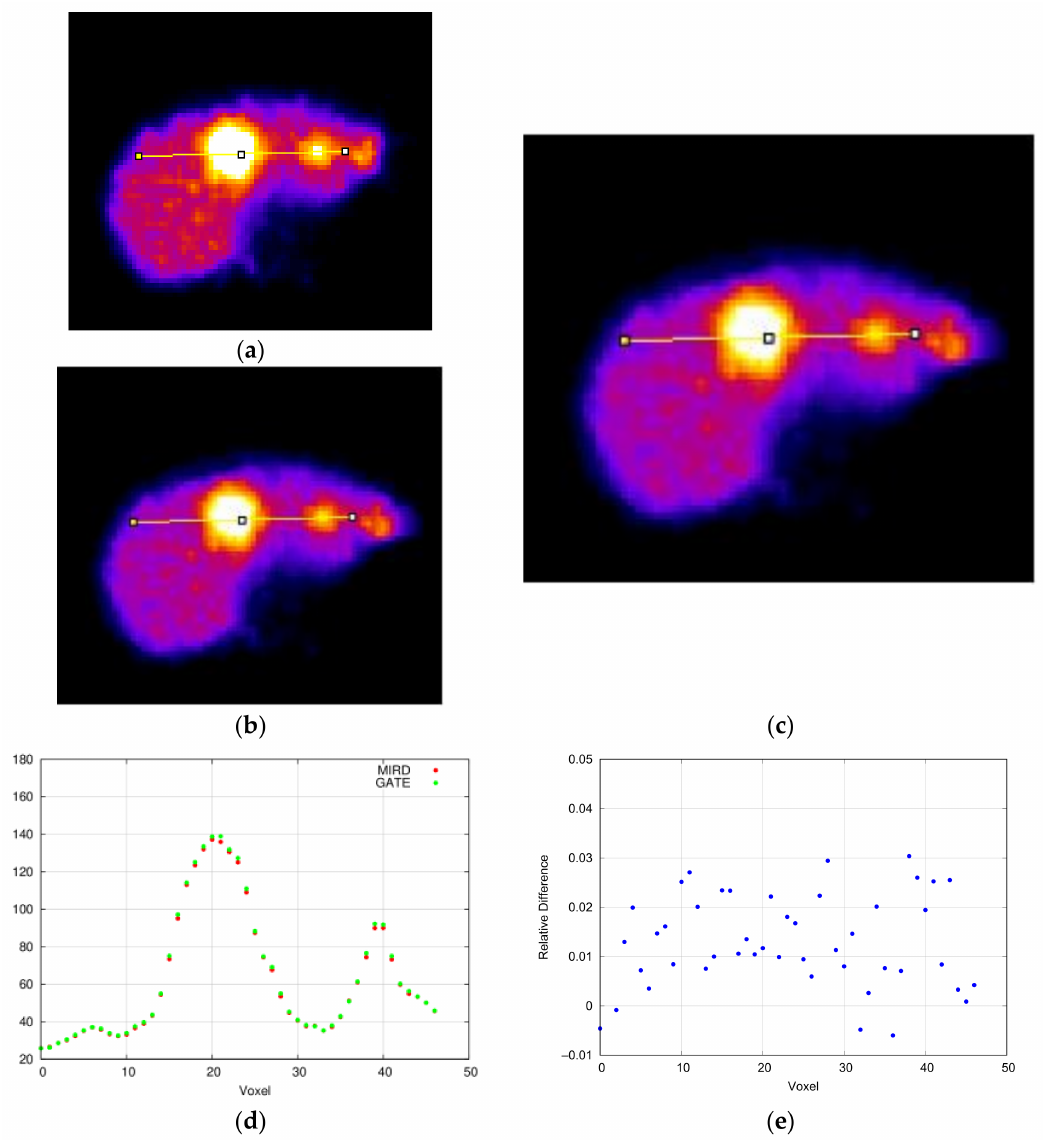
Figure 5. Absorbed dose profile for the NUL-a case and comparison. ( a ) Absorbed dose image obtained with the MIRD scheme and absorbed dose profile selection; ( b ) absorbed dose image obtained with GATE and absorbed dose profile selection; ( c ) relative difference (RD) image for the whole slice; ( d ) comparison between absorbed dose profiles; ( e ) plot of the absorbed dose RDs for each voxel of the